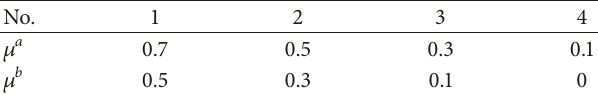
Table 4: Interval bounds for overall heat transfer